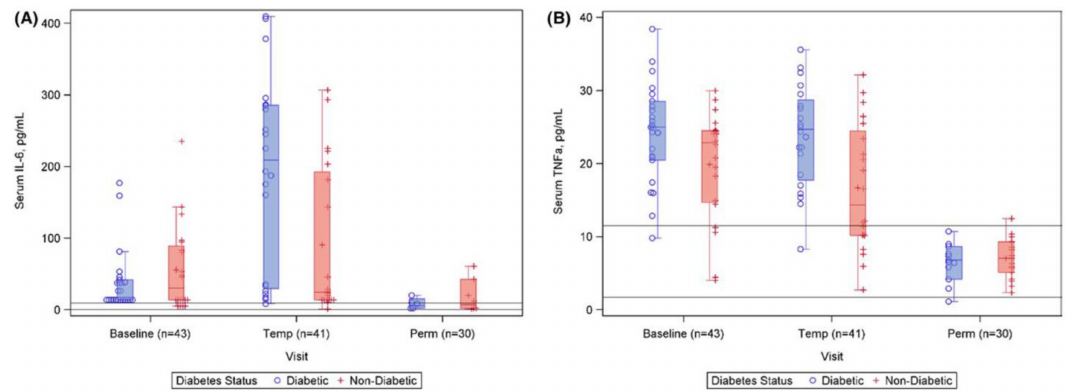
Figure 3. Anti-inflammatory e ff ect. Inflammation changes during the NIH DiaComp study: baseline, 6 days and 6 months using low and moderate energy GES, stratified by diabetes status, measured by IL-6 (pg / mL) ( A ) and TNF- α ( B )